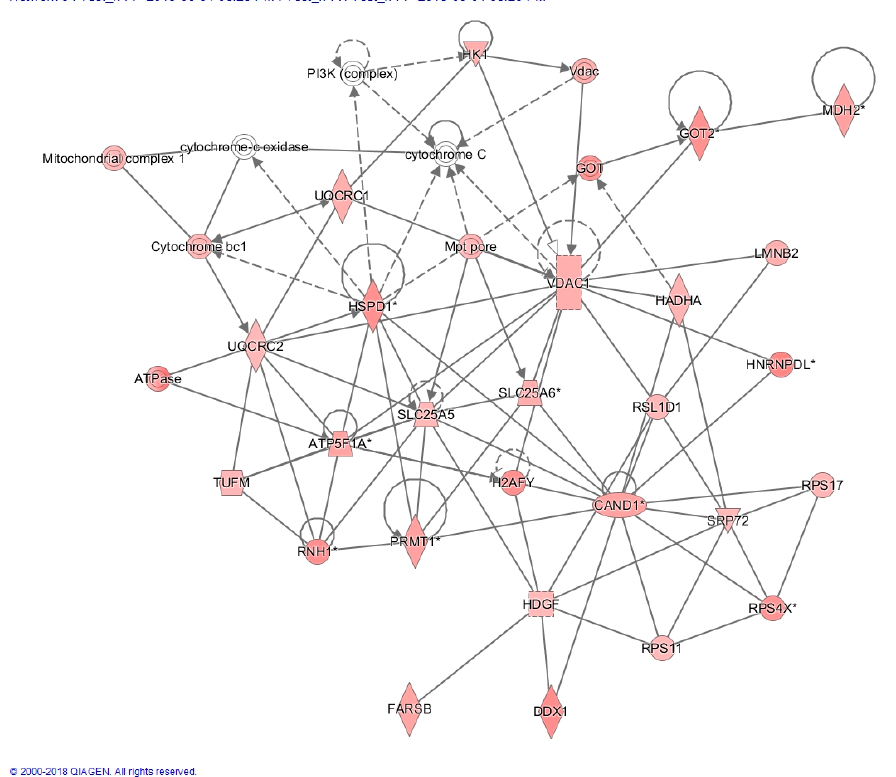
Figure 5. IPA pathway analysis shows one of the enriched networks (Network 3), which is related to energy production.